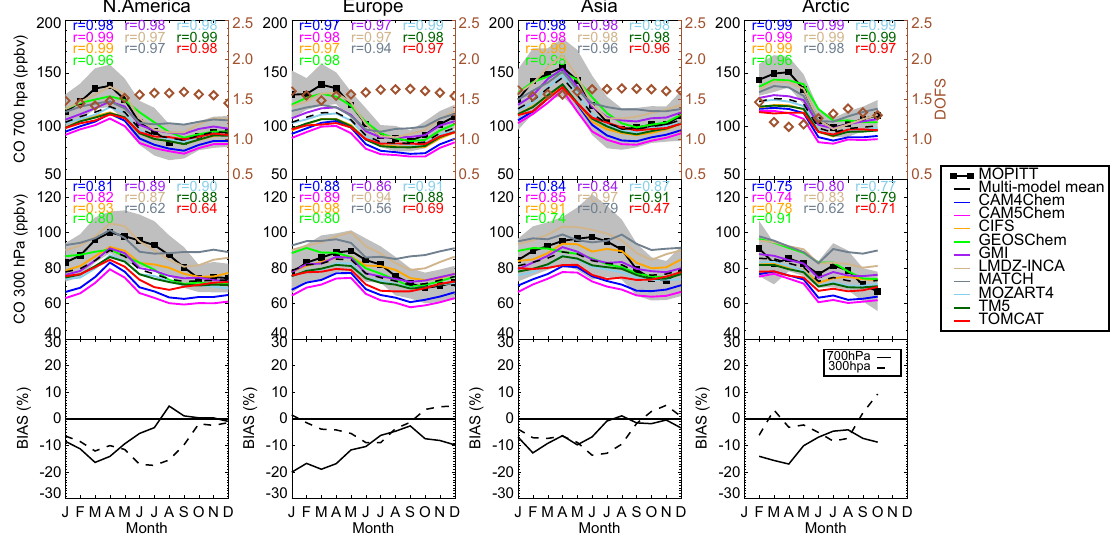
Figure 6. Monthly mean 2008 MOPITT-retrieved CO compared to models at 700hPa (top) and 300hPa (middle). The monthly mean percent bias (bottom) at 700hPa (solid lines) and 300hPa (dashed lines) are also shown. The models have had the MOPITT averaging kernels applied and retrievals with DOFS less than 1 removed. The grey shaded area shows 1 σ of the MOPITT concentrations over the regions at the relevant pressure